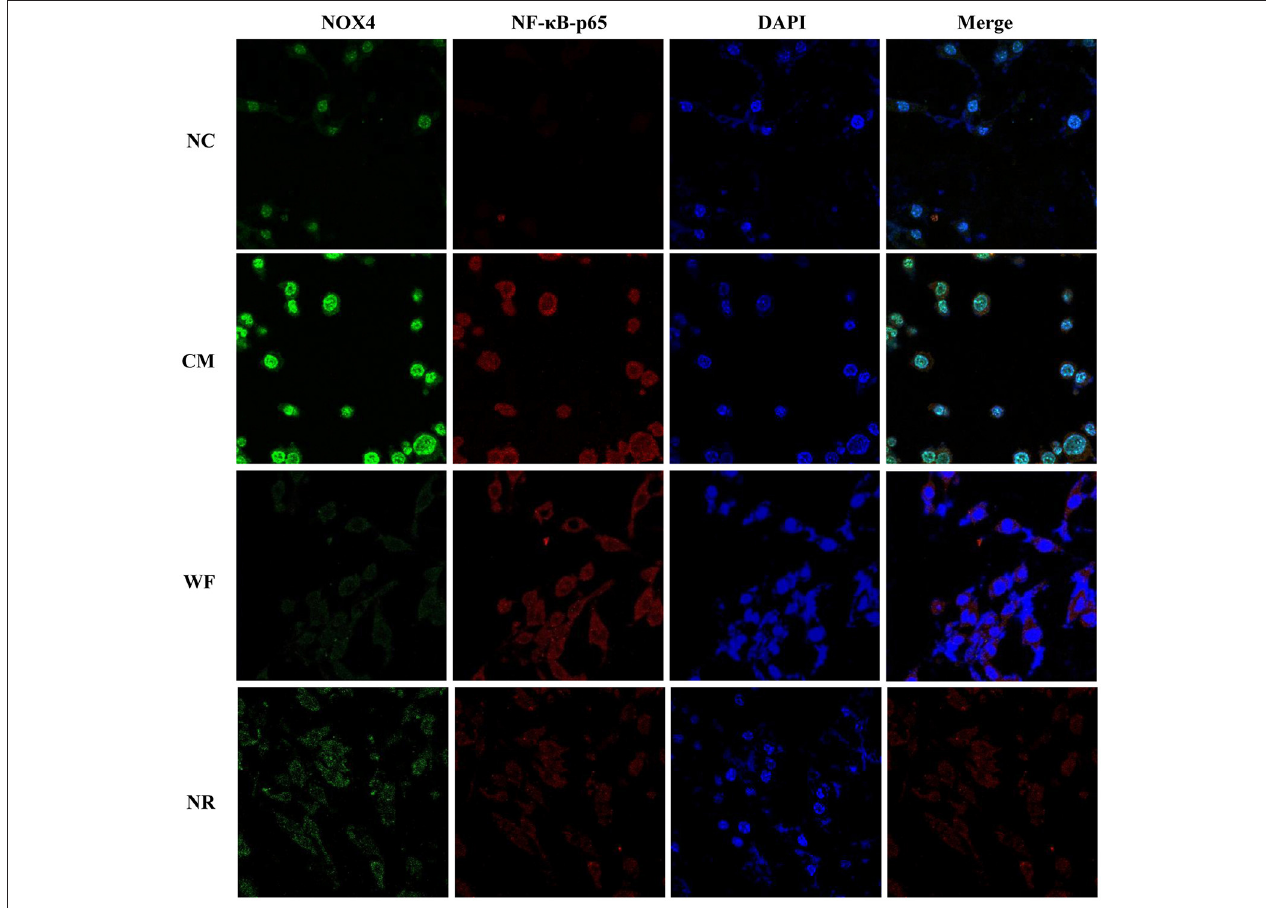
FIGURE 6 | Effects of the waterfall forest environment (WF) on the expression of NOX4 and NF- κ B p65. The expression of NOX4 and NF- κ B p65 was detected by immunofluorescence staining. Scale bars are 50 µ